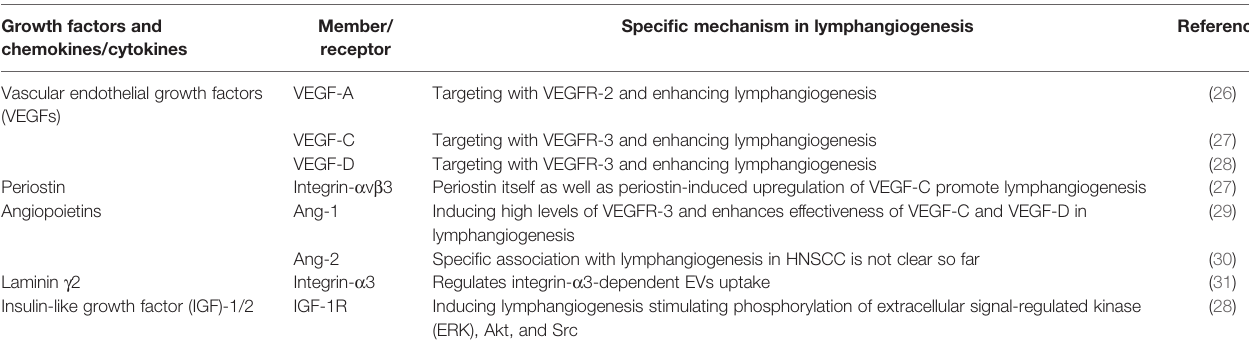
TABLE 1 | The role of different molecular in inducing lymphangiogenesis in head and neck squamous cell carcinoma (HNSCC). Growth factors and Member/ chemokines/cytokines